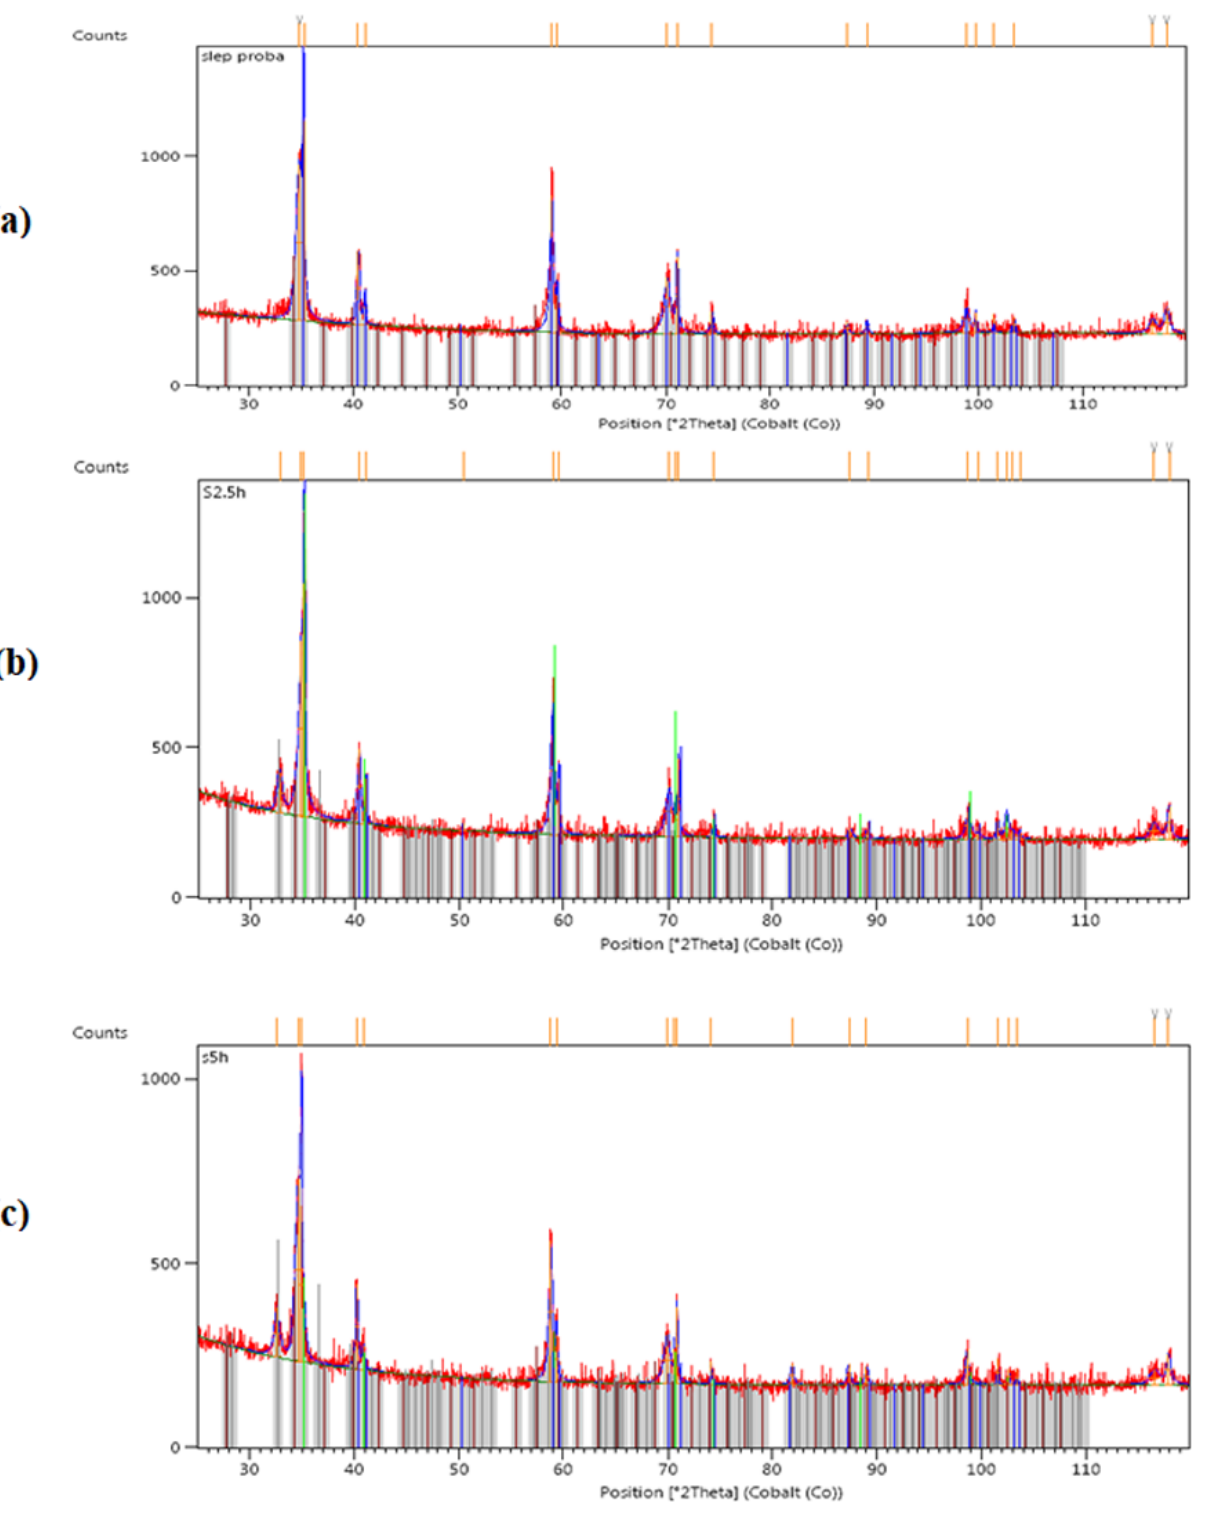
Figure 1: Diffraction pattern of samples: (a) reference, (b) after ageing process t = 2.5 h, (c) after ageing process t = 5